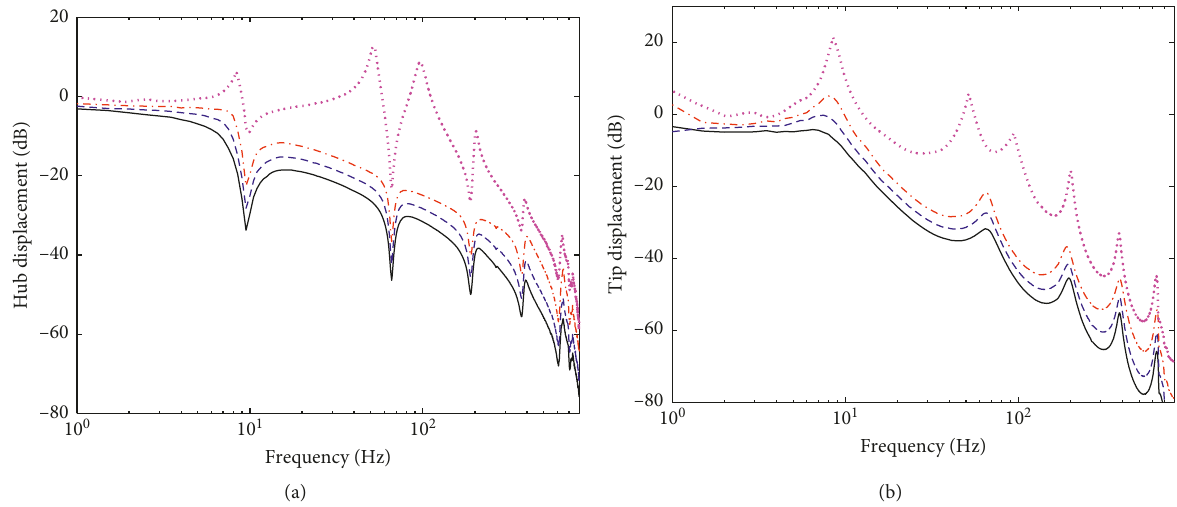
. 5 and their predictions (dashed) using the positive-definite e (cid:31) 0 ” and “ ,” are indicated at the ∇ o